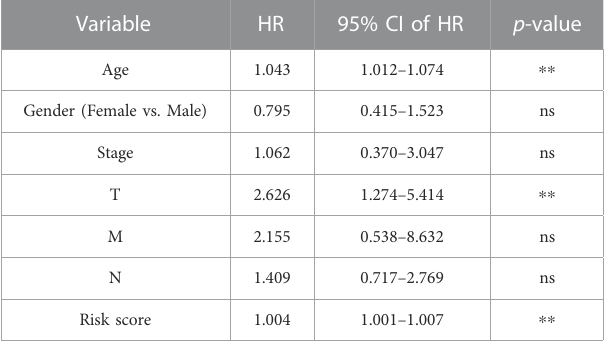
TABLE 3 Multivariate independent prognosis analysis results of training dataset.